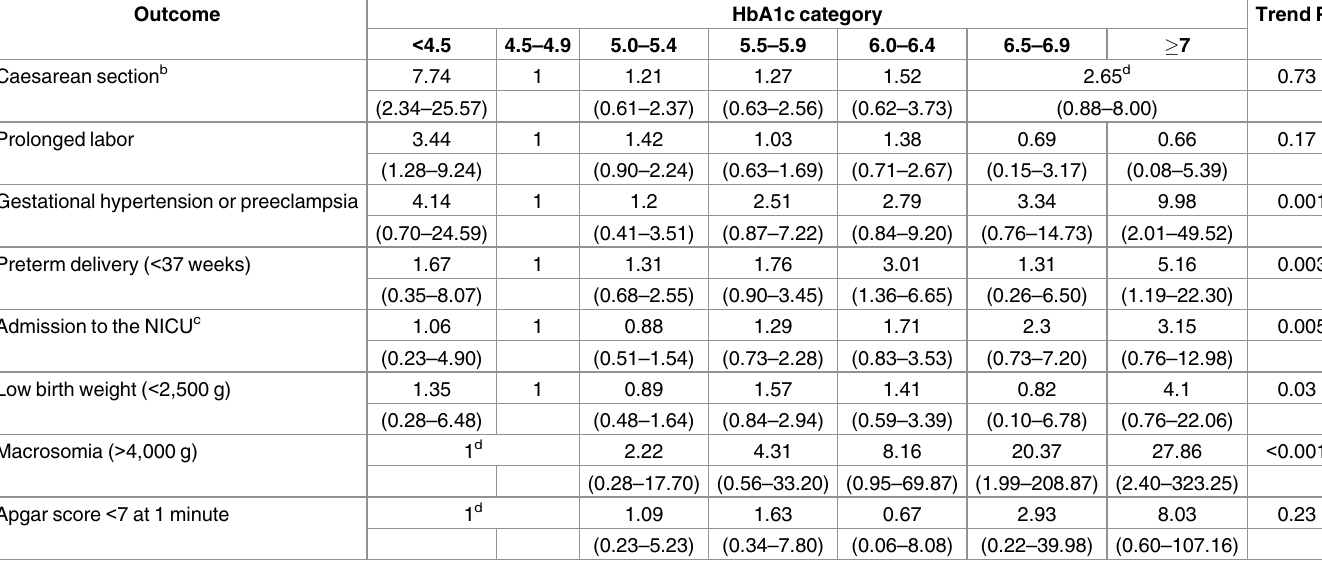
Table 2. Estimated odds ratios of pregnancy outcomes according to multiple regression analysis (n =